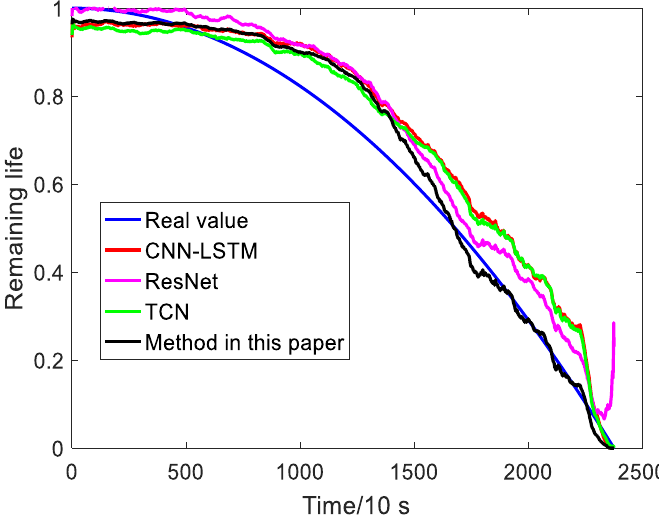
Figure 13. RUL prediction results of each method on test bearing 1 − 3.